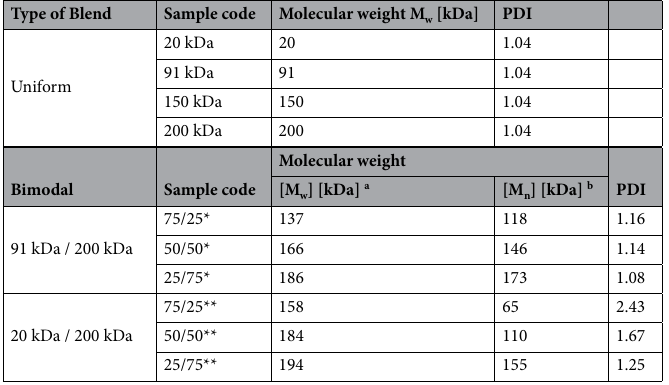
Table 1. List of polymer blends that were used for spin-coating. a Weight average molecular